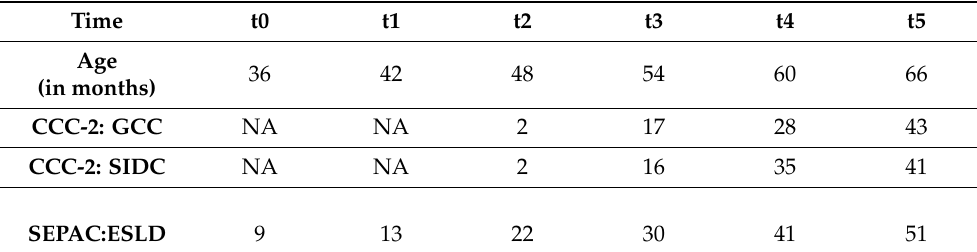
Table 4. Results of the children’s communication checklist for four assessment points (CCC-2) and the scale for evaluation of psychophysiological abilities of children for six assessment points (SEPAC).